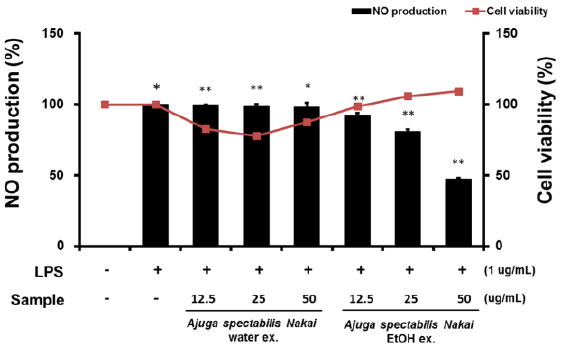
Figure 5. Determining NO production and cell viability in RAW264.7 cells. Cells were pre-treated with AS-W, AS-E for 6 h and then co- treated with LPS (1 μg/mL) for 18 h. * p < 0.05 compared to the cells without the treatment, and ** p < 0.05 compared to the cells treated with LPS alone.